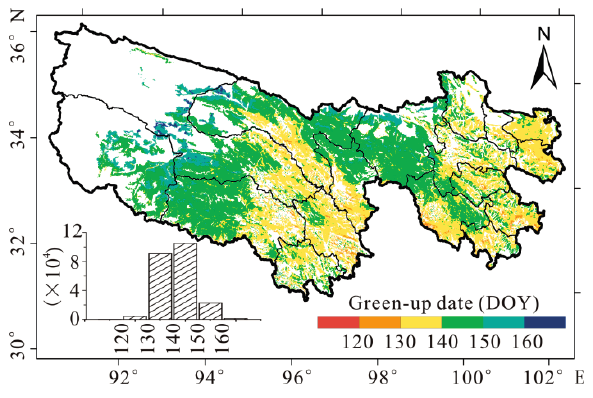
Figure 4. Spatial pattern of the averaged vegetation green-up dates during 1999–2013 in the TRHR.